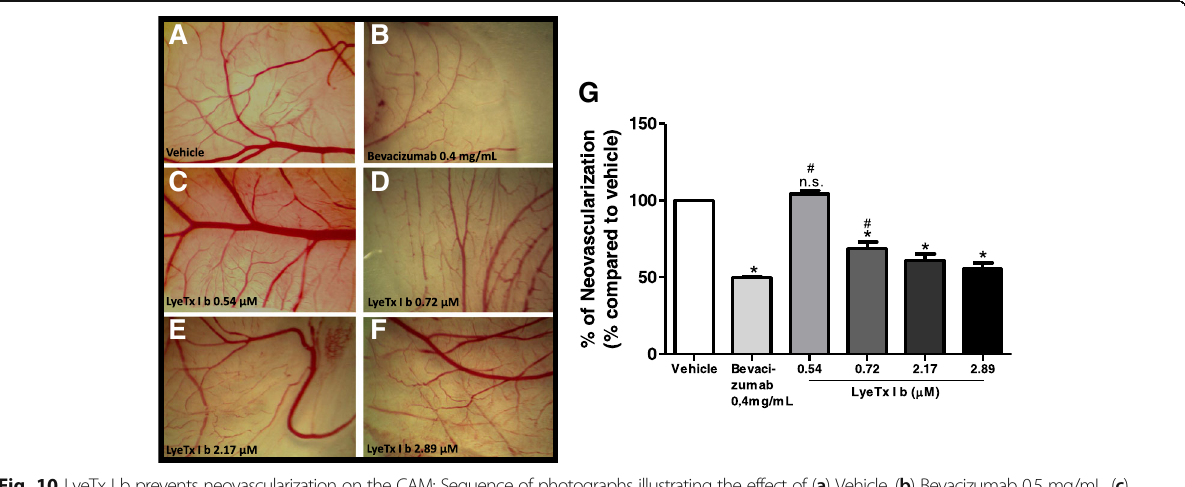
Fig. 10 LyeTx I b prevents neovascularization on the CAM: Sequence of photographs illustrating the effect of ( a ) Vehicle, ( b ) Bevacizumab 0.5 mg/mL, ( c ) LyeTx I b 0.54 μ M, ( d ) LyeTx I b 0.72 μ M, ( e ) LyeTx I b 2.17 μ M and ( f ) LyeTx I b 2.89 μ M on the CAM over a 72-h period. g Graph shows the measure of vascularization after exposure to untreated eggs (Vehicle) or treatment with LyeTx I b (0.54 μ M, 0.72 μ M, b 2.17 μ M or 2.89 μ M). Data represent the ± SEM of number of pixels of twelve independent experiments. * indicates significant difference as compared to vehicle ( p <0.05). # indicates significant difference as compared to Bevacizumab (p<0.05). n.s. indicates no significant difference as compared to vehicle (p>0.05). Abbreviations: SEM, standard error of the